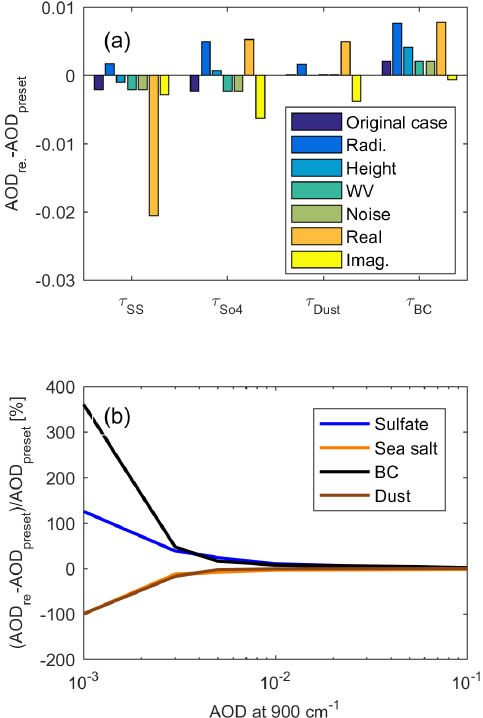
Figure 5. (a) The difference between the retrieved AOD in the orig- inal case with preset values and that with several possible pertur- bations (see Table 2). (b) The relative uncertainties in the AOD in the original cases with several preset values. Note that the artificial spectra with several preset values in panel (b) mean that the AOD values of aerosols are set from 0.001 to 0.1. Using the same method but for different preset AOD values, the reliable range of AOD val- ues is given in panel (b)